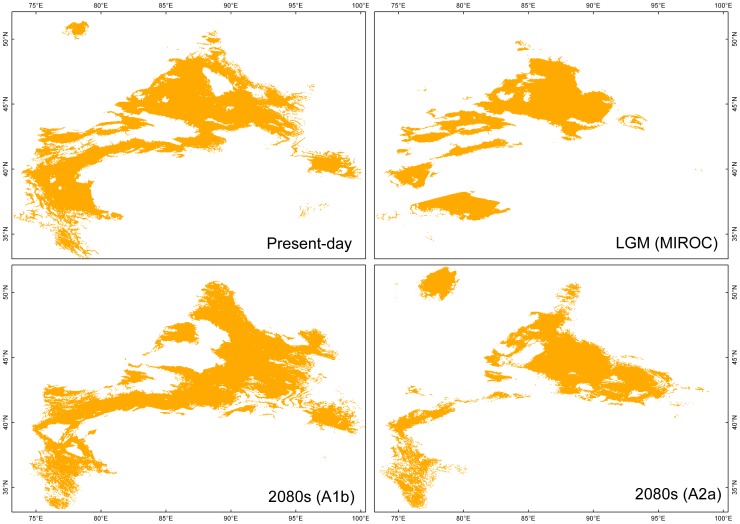
Modelling distribution of Clematis songorica.Maps depicting potential distribution of Clematis songorica in arid Eastern Central Asia during present-day and at LGM based on the MIROC model, and future (2080’s) based on the A1b and A2a scenarios.